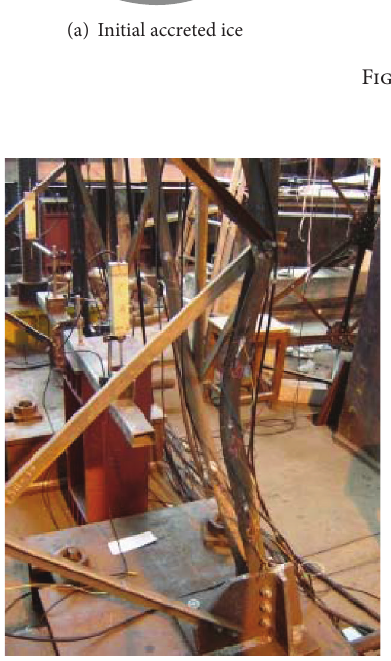
Figure 14: Failure phenomena of single-panel subassemblage with- out diaphragms.